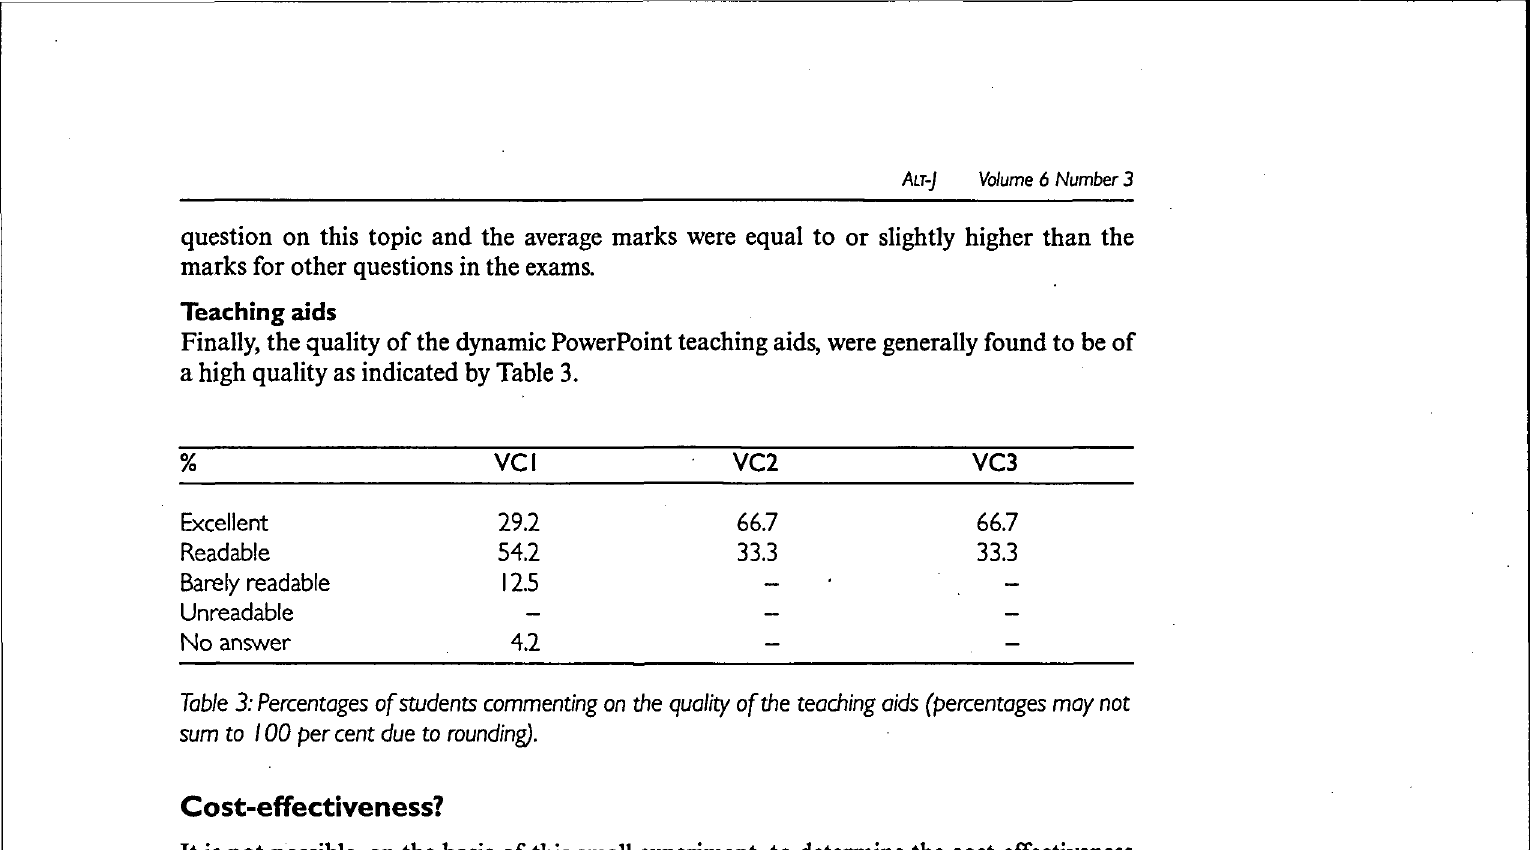
Table 3: Percentages of students commenting on the quality of the teaching aids (percentages may not sum to 100 per cent due to